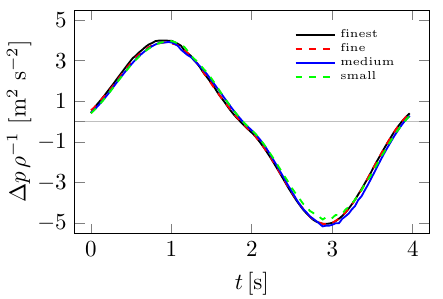
Figure 5. Influence of computational mesh on pressure drop (cid:31) p .